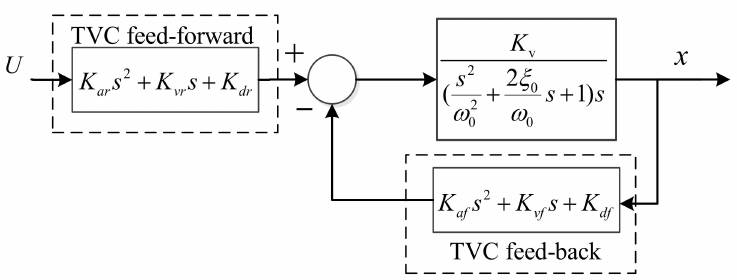
Figure 1. Conventional three variable control for shaking table test